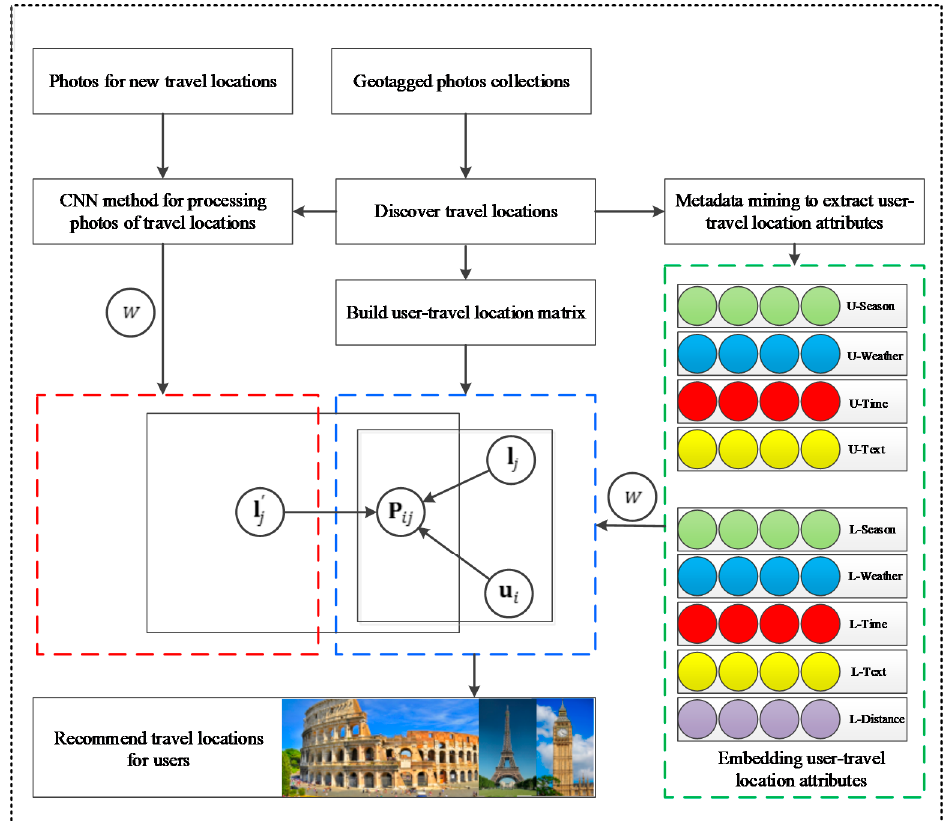
Figure 2. The framework of the proposed methods: weighted matrix factorization (WMF) part in the middle (dashed blue); convolutional neural network (CNN) part on the left side (dashed red); embedding methods on the right side (dashed green) (best seen in color).